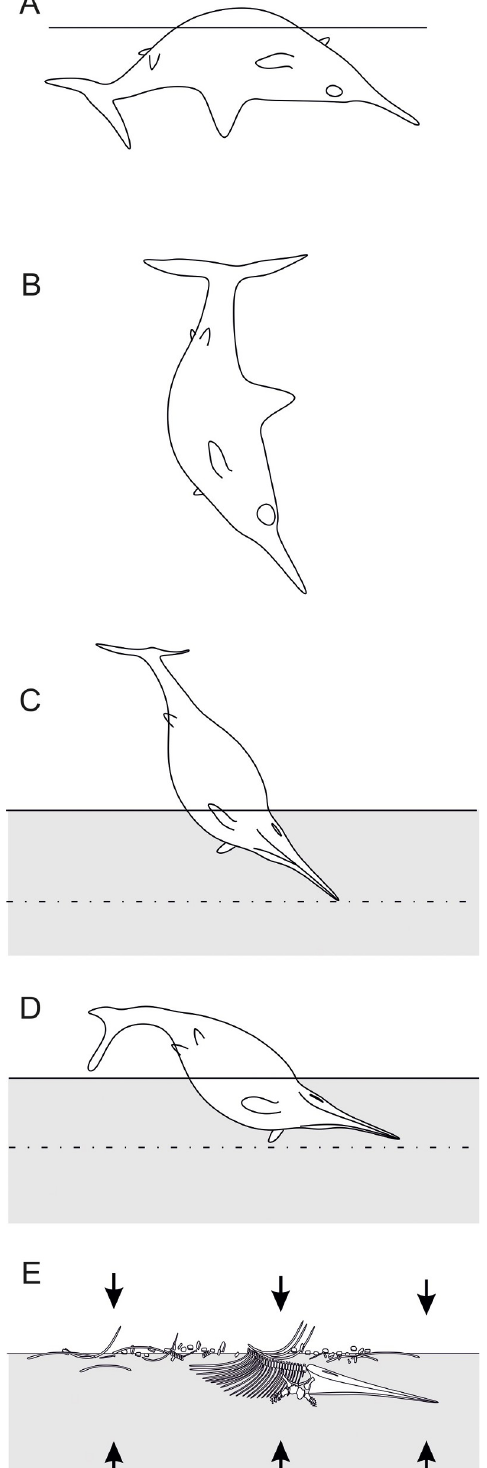
Fig 20. Ossified ligaments and decayed internal organs of Thalassodraco etchesi , MJML K 1885. A, ossified ligaments across the neural spines. B, SEM image of the ossified ligament. C, black material, presumed decayed internal organs, in the upper body cavity. D, magnified view of the black material in the body cavity. Scale bar in A, D